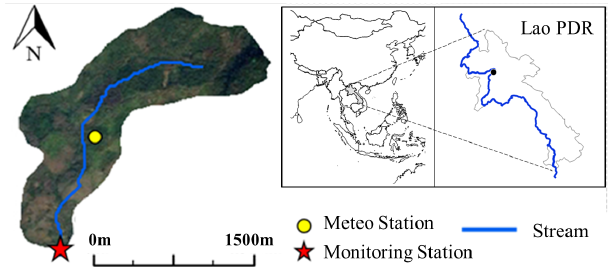
Figure 1. Location of the study area. The study area is located near Luang Prabang in the northern Lao PDR. The gauging and moni- toring station is located at the outlet of the catchment, where water level is recorded and where water samples are collected for E. coli concentration measurement. Climate data were measured at the me- teorological